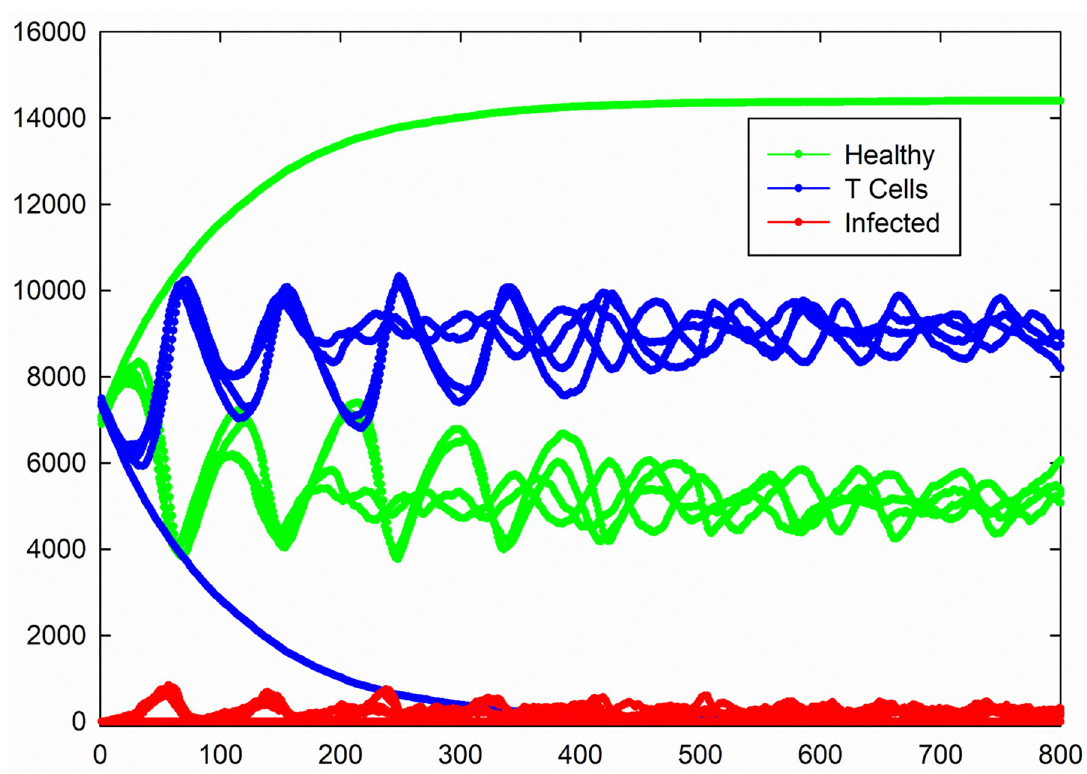
Fig 9. Total number of healthy, infected, and T cells versus time for 5 different samples for the case of P I = 1, P T = 0.4, P H = 0.4, and P D =